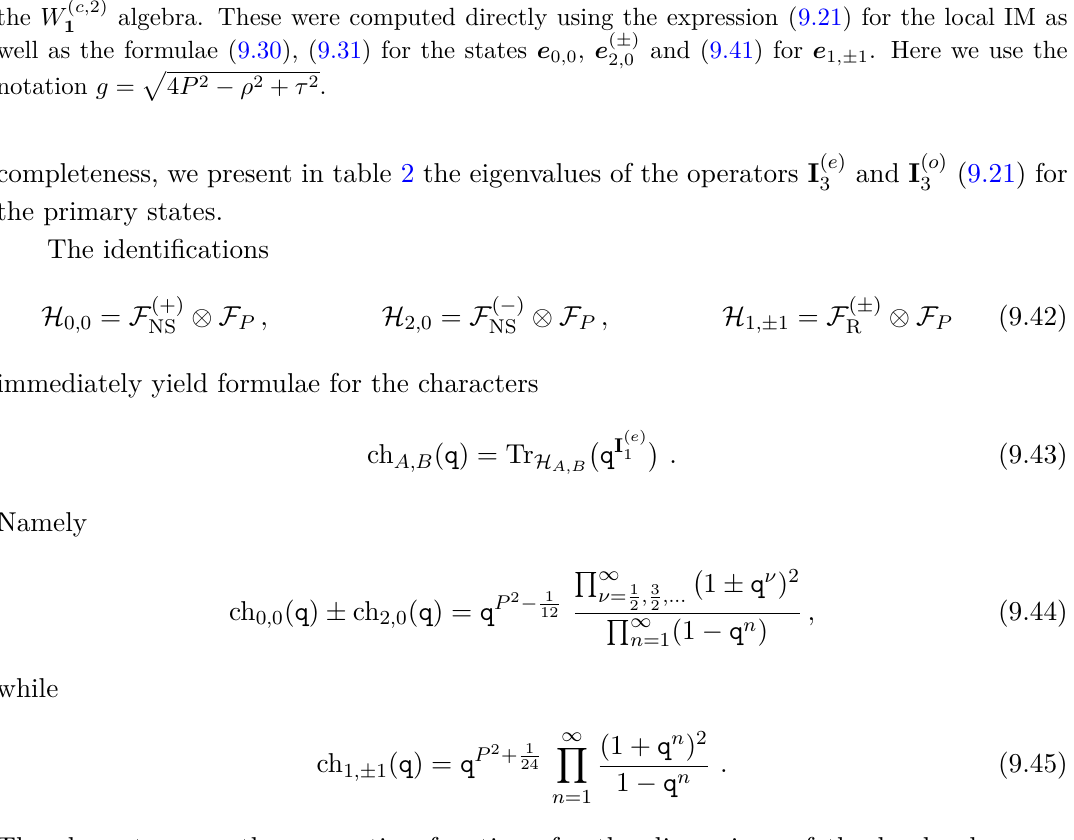
and I ( o ) for the primary states of 3 3